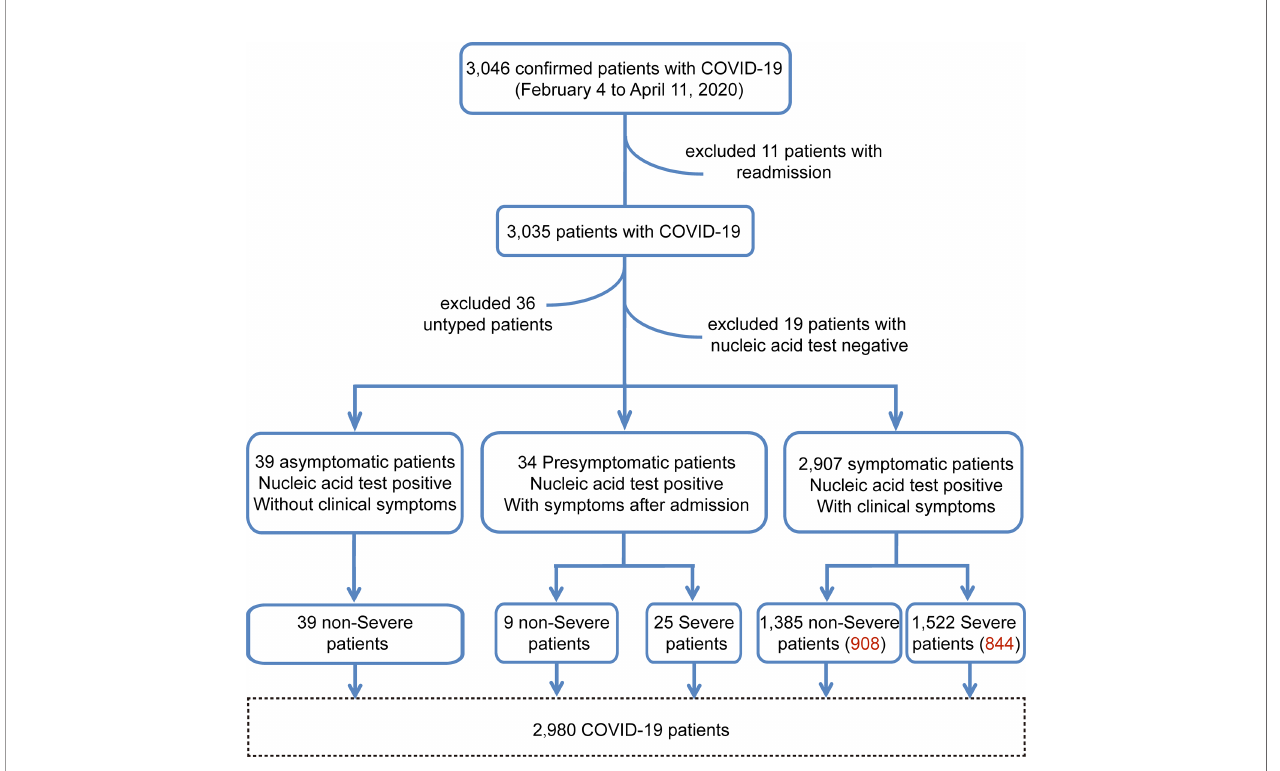
Figure 4B . It is noteworthy that the top fi ve indicators (brain natriuretic peptide (BNP), IgG, IgM, glucose (GLU), and DD) might have similar strati fi cation ef fi ciencies (AUC=0.86, 5-fold cross-validation 95% CI, 0.73 – 1.00, Figure S2A